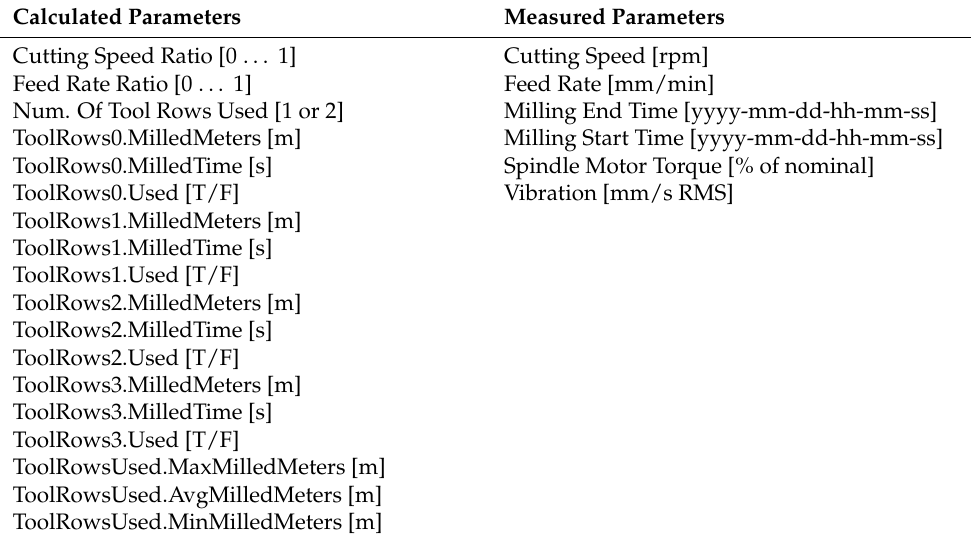
Table 2. Calculated and measured data from the manufacturing